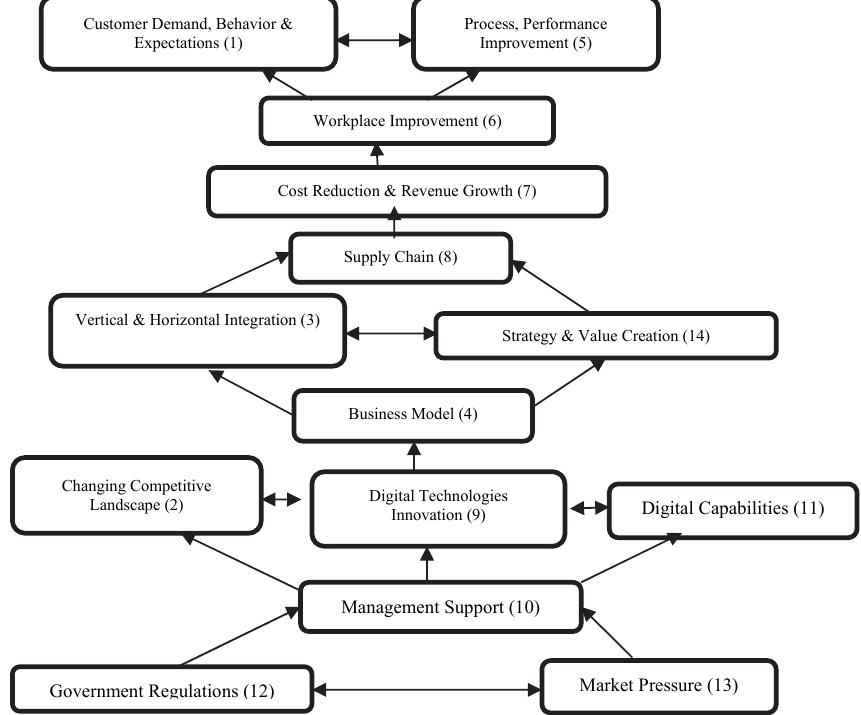
Fig. 4. Proposed ISM based model of DT